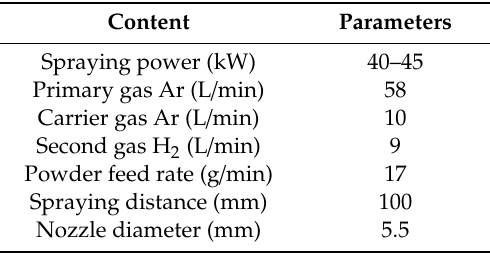
Table 1. Detailed parameters of the sprayed MoSi 2 -ZrB 2